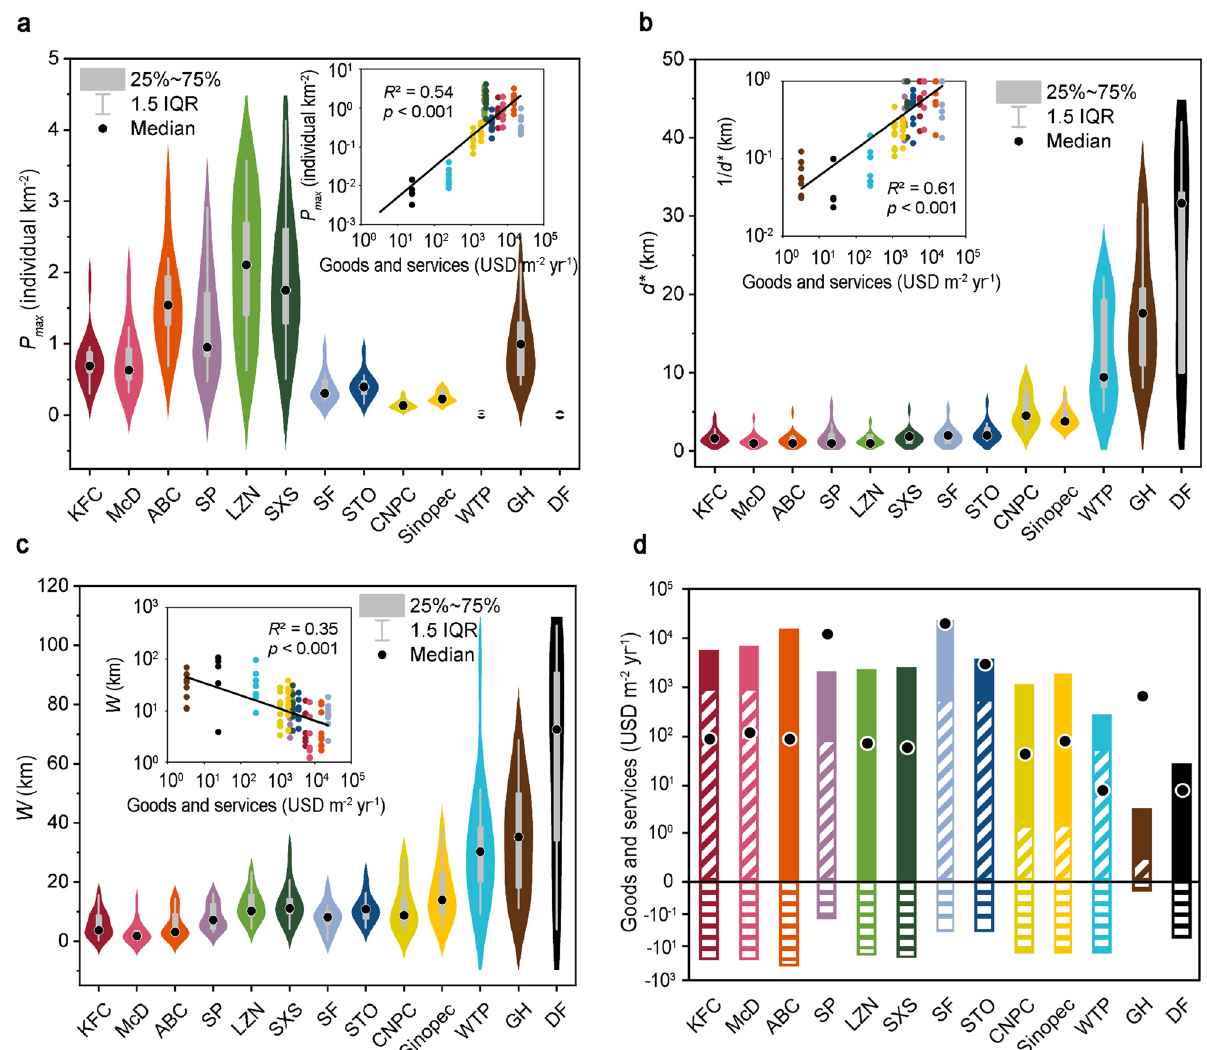
Figure 2. Relationship between the characteristics of the city functional component density distribution curves and ecosystem services. ( a ) P max of the different types of city functional components in the case cities. The inset shows the relationship between P max and the ecosystem services (the inset does not include P max of the GHs because the counting method for GHs is different from that for the other types of components). ( b ) d* of the different types of city functional components in the case cities. The inset shows the relationship between 1/ d* and the ecosystem services. ( c ) W of the different types of city functional components in the case cities. The inset shows the relationship between W and the ecosystem services. ( d ) Ecosystem services of the various city functional components. The solid column indicates the target services, the diagonal filled column indicates the positive accompanied services, the horizontal filled column indicates the negative accompanied services, and the black dot indicates the ecological index (the ratio of the target services to the negative accompanied services). The abbreviations of the component names are the same as those in Fig.